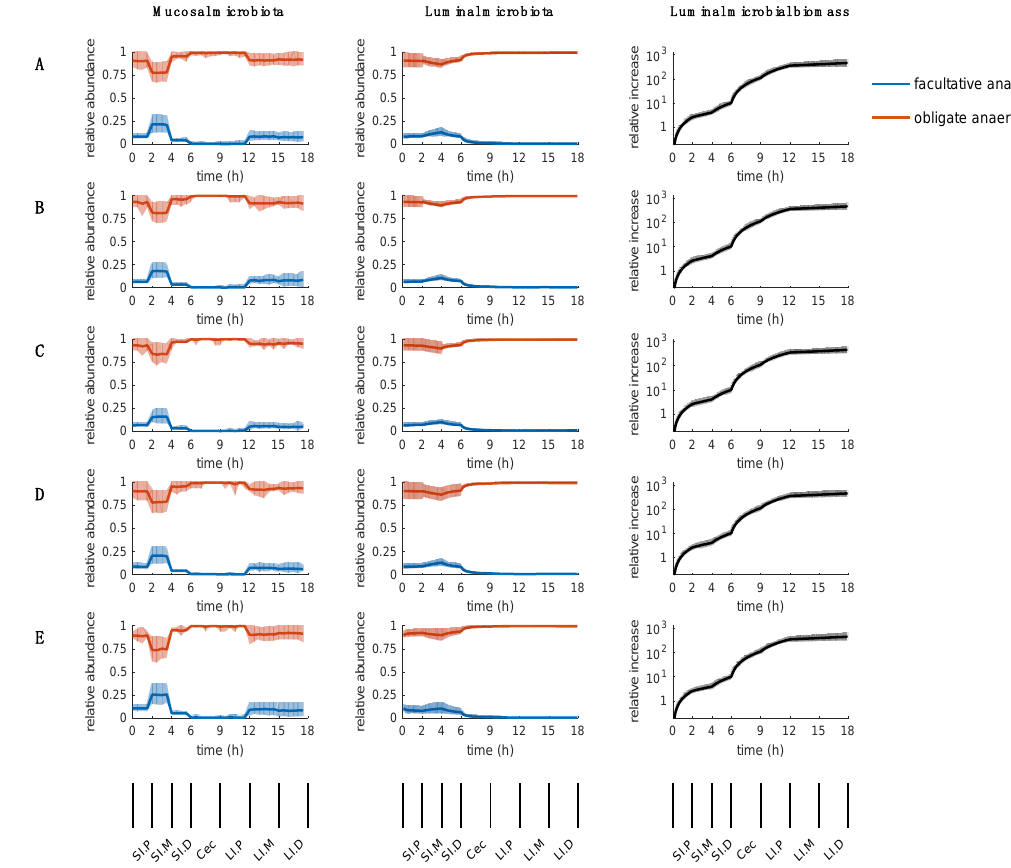
Figure 6. Varying the fraction of the total oxygen available to luminal microbiota α lum oxygen as detailed in Table 4. ( A ) Default, decreasing from 0.2 to 0. ( B ) Test 1, decreasing from 0.4 to 0. ( C ) Test 2, constantly 0.4. ( D ) Test 3, constantly 0.2. ( E ) Test 4, constantly 0.